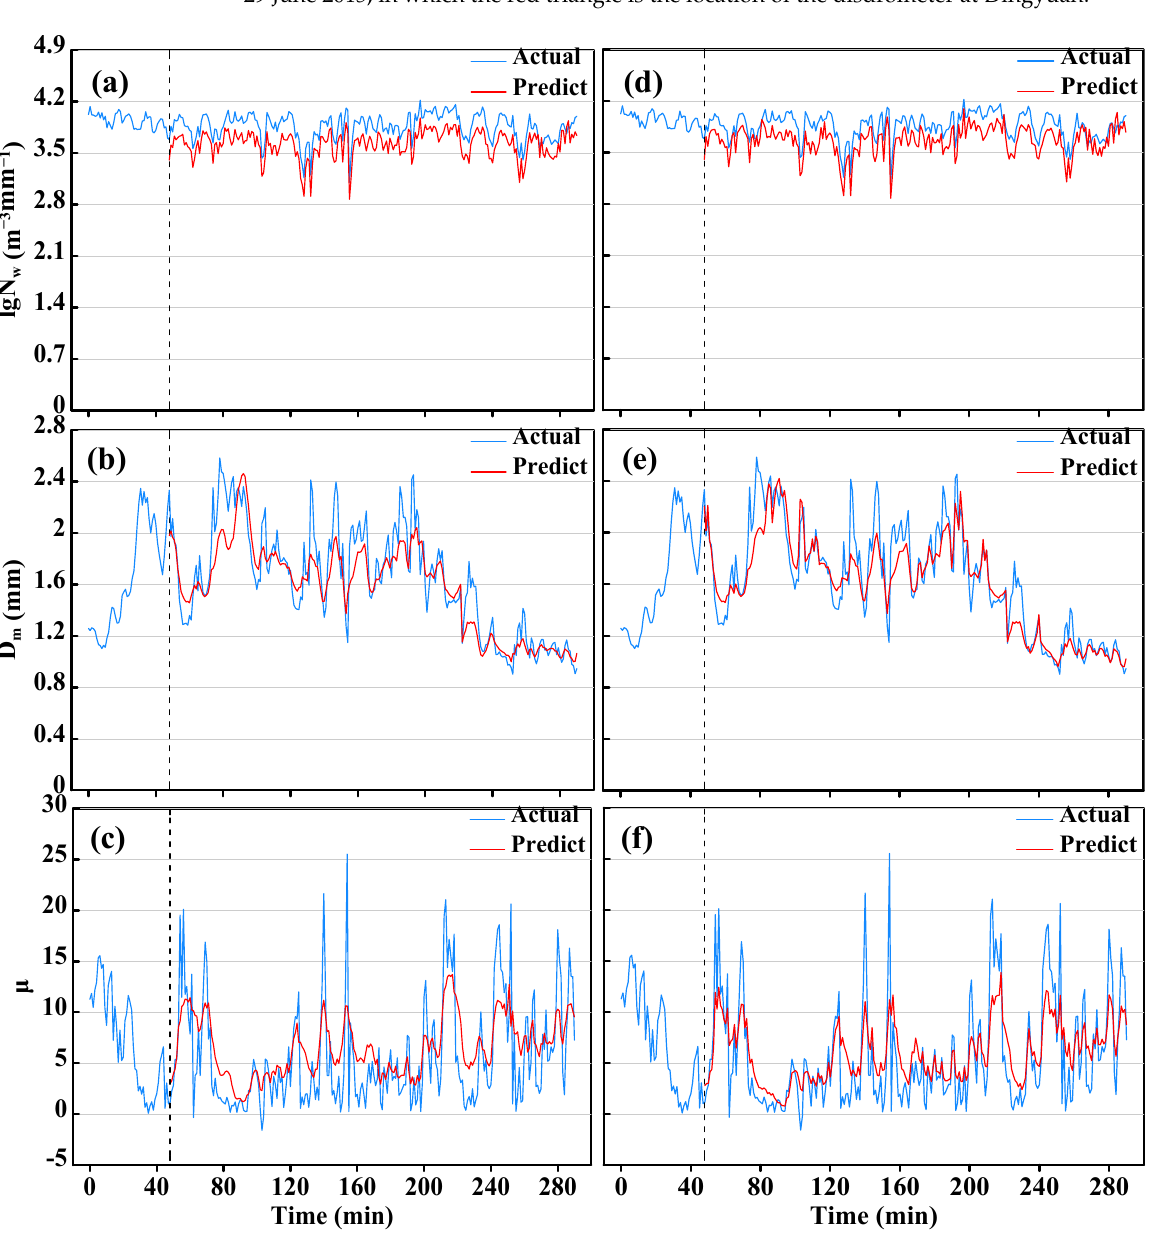
Figure 16. The curve of the 30-min prediction for the convective cloud precipitation case, in which the horizontal axes are rainfall duration time (min); vertical axes are ( a , d ) lgN w , ( b , e ) D m (mm), and ( c , f ) μ; the red and blue curves represent the predicted and actual values; and the vertical dot- ted line is at the minute of T step + M pred . Modeling with MLF is shown on the left ( a – c ), and with SLF on the right ( d – f ). Results of 30-min Prediction Figure 16 shows the evolution of the observation and 30-min prediction values in this convective rainfall event. Compared with the two types of precipitation mentioned above, the D m values of cumulus were larger, and the maximum of D m exceeded 2.4 mm. lgN w were distributed between 3.5 to 4.2, and μ appeared as negative values too. When D m was large, μ was smaller, and, on the contrary, when D m was small, μ was larger. Obviously, the prediction effect of the three parameters was lower than the above two cases, which